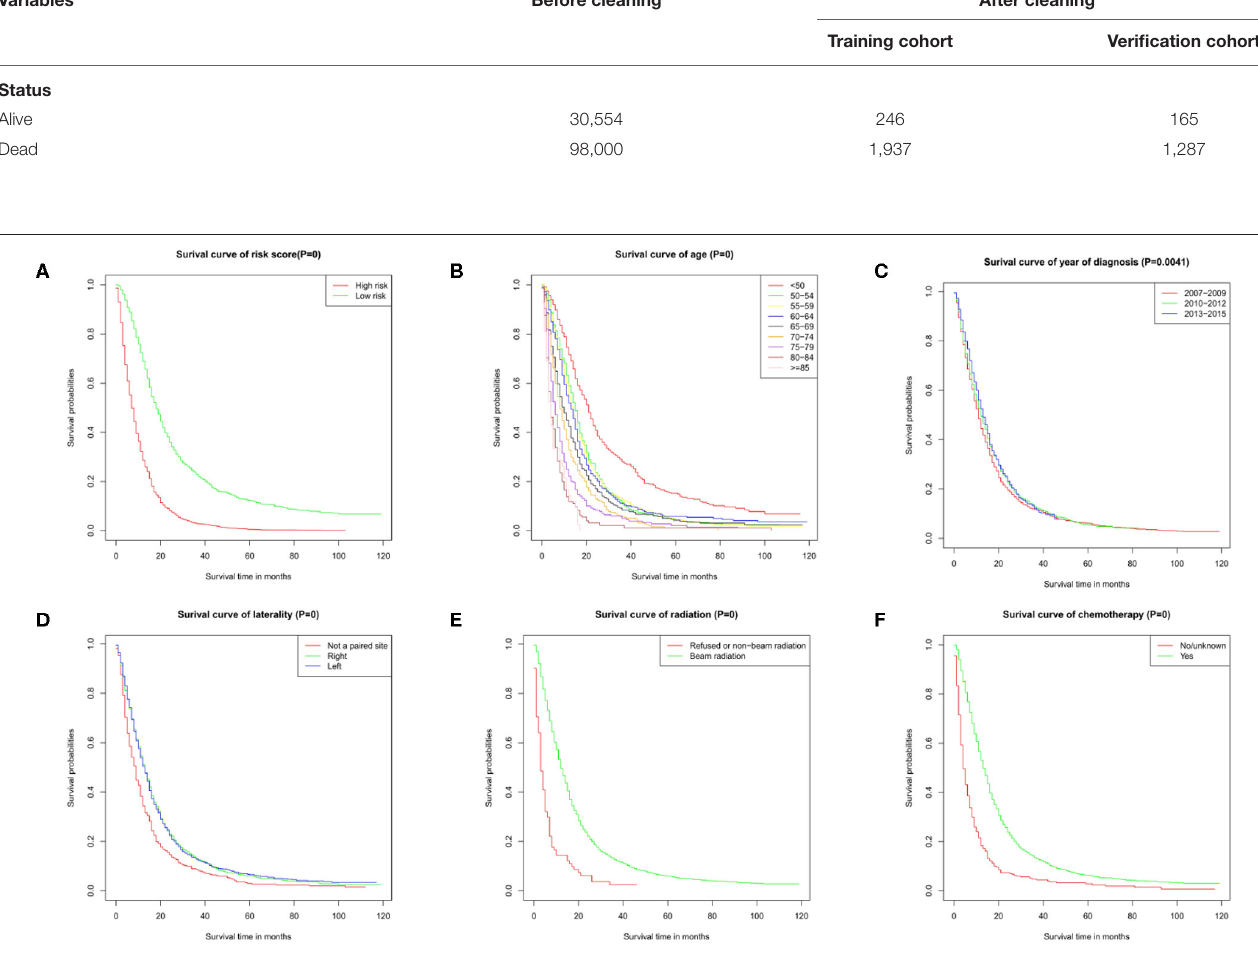
year of diagnosis, laterality, radiotherapy, chemotherapy were independent risk factors for overall survival (OS) ( Figure 2A